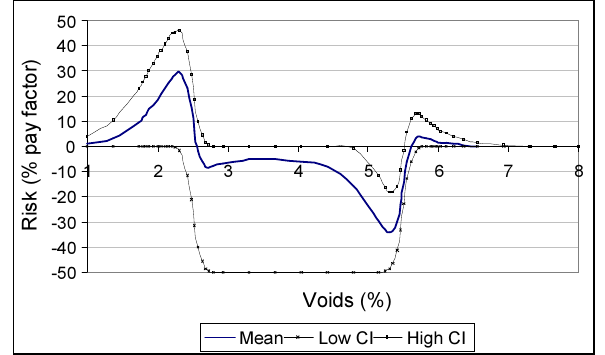
Fig. 3. Mean squared error (MSE) for one hidden layer network